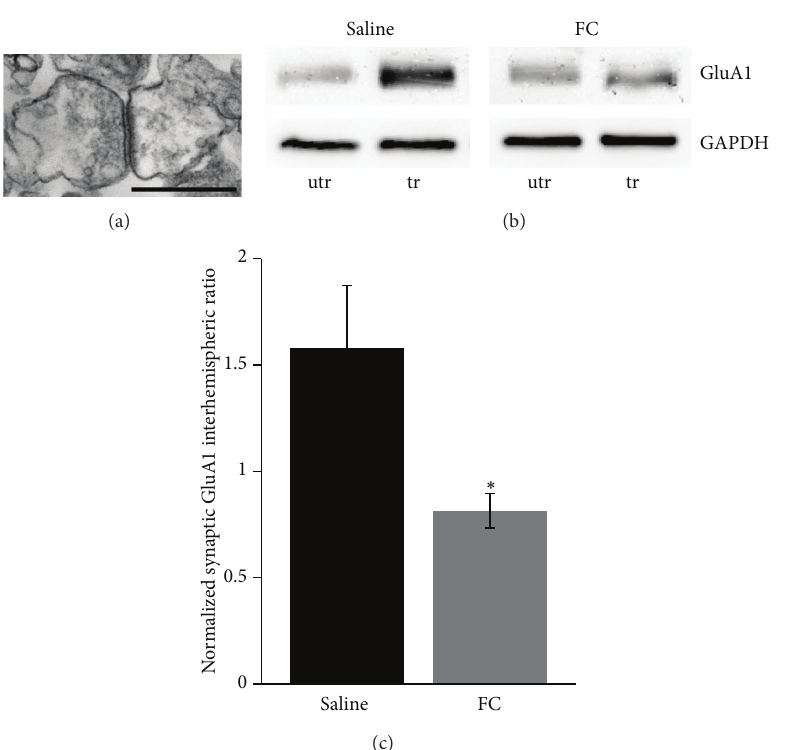
Figure 4: Astrocyte function is necessary for motor-skill learning induced synaptic GluA1 insertion. (a) An example electron micrograph demonstrating the presence of synaptosomes. Scale bar: 1 micrometer. (b) Western blots of synaptic GluA1 from forelimb M1 regions of untrained (utr) and trained (tr) hemispheres of 1 day trained mice following ICV injections with saline or FC. (c) Interhemispheric ratios (trained/untrained) of synaptic GluA1. ∗ 𝑃 < 0.05